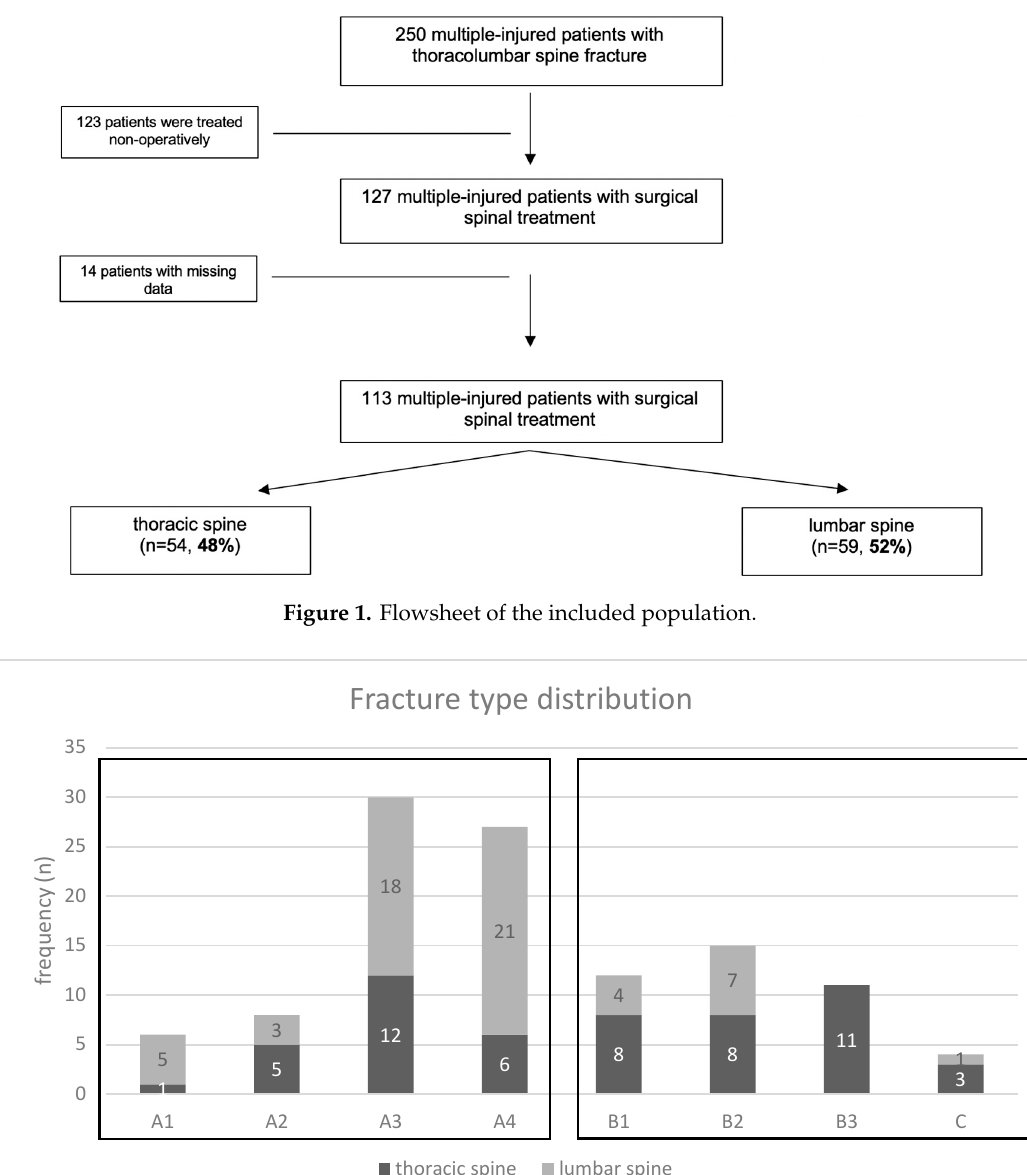
Figure 2. Distribution of the fracture type within the thoracic and lumbar spine of the surgically treated patients.